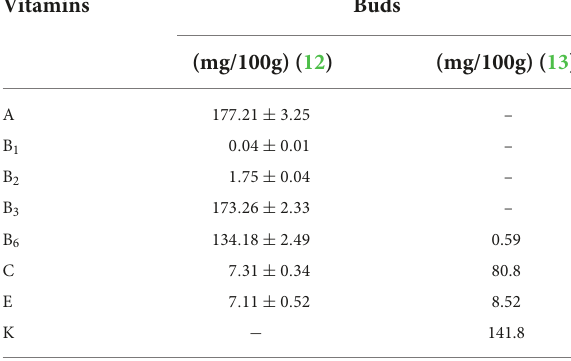
TABLE 5 Vitamin composition of S. aromaticum